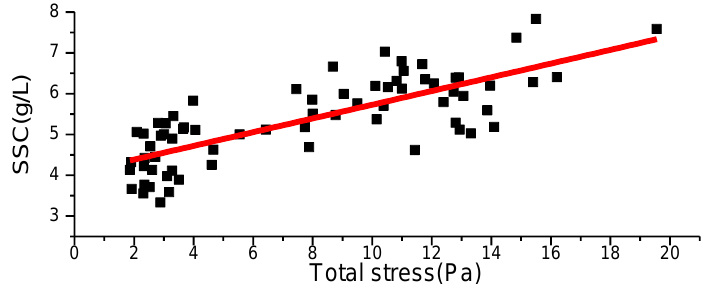
Figure 8. Suspended sediment concentration (SSC) as a function of the shear stress calculated by Equation (5) from 13–17 December 2014 (linear fit of the total stress Pearson’s r is 0.78).